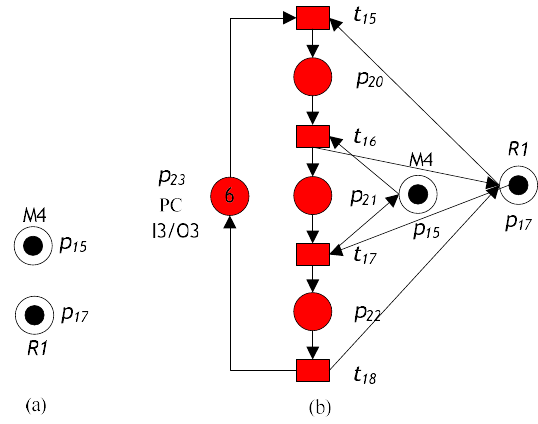
Figure 17. A reconfigured S 3 PR net by removing a machine. ( a ) Left hand side net L . ( b ) Right hand side net R .